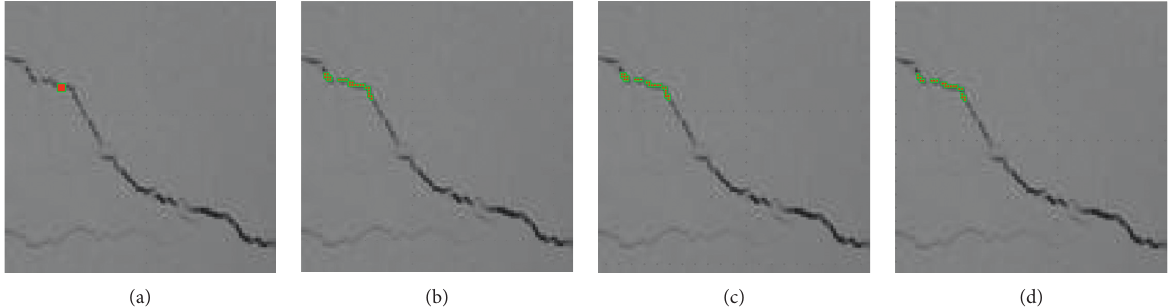
Figure 27: Percolation result of a clear crack pixel using different striding strategies: (a) raw image; (b) fixed stride percolation; (c) linear stride percolation; (d) quadratic stride